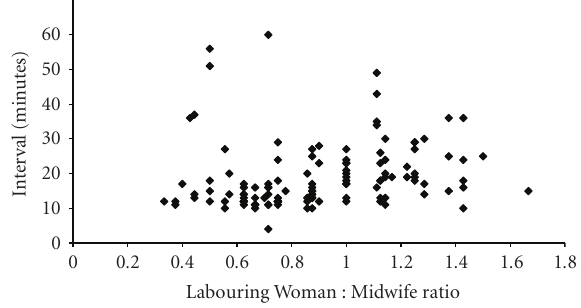
Figure 9: Preoperative time in theatre versus Labouring Woman: Midwife ratio (grade 1).